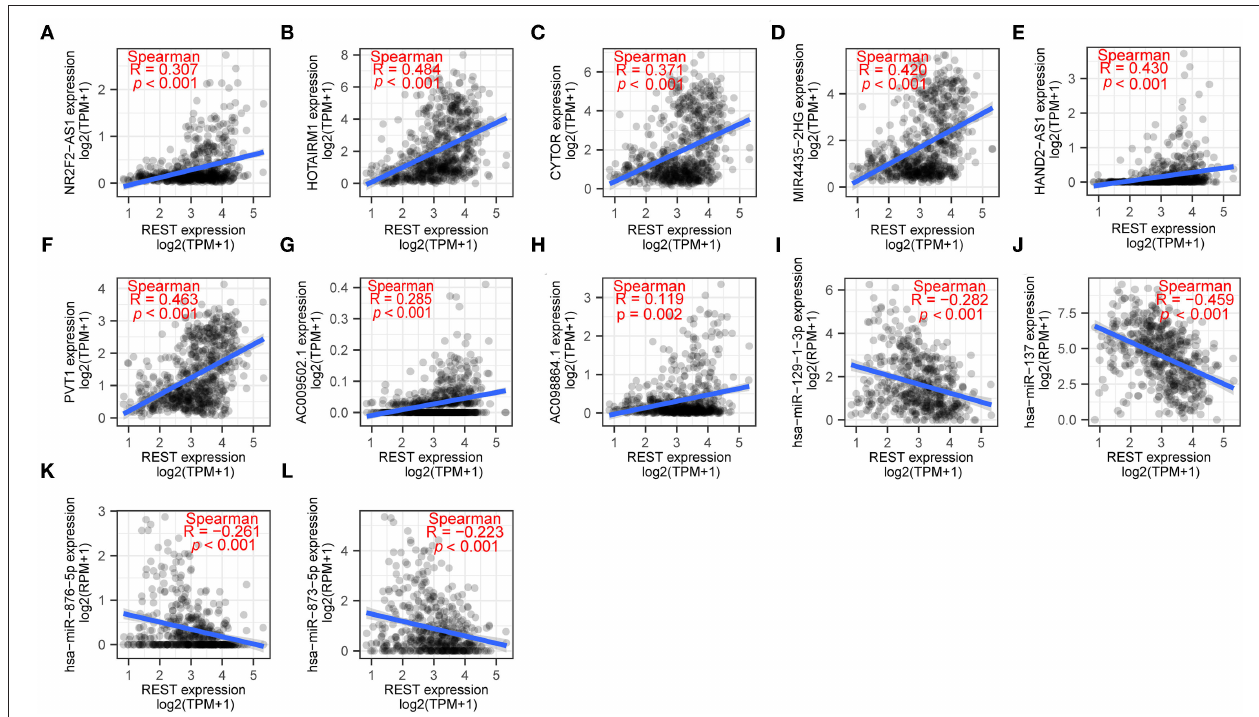
FIGURE 6 | The correlation of REST and its hub genes of ceRNA network. The correlation between REST and NR2F2-AS1 (A) , HOTAIRM1 (B) , CYTOR (C) , MIR4435-2HG (D) , HAND2-AS1 (E) , PVT1 (F) , AC009502.1 (G) , AC0098864.1 (H) , hsa-miR-129-1-3p (I) , hsa-miR-137 (J) , hsa-miR-876-5p (K) , hsa-miR-873-5p (L) . Data were analyzed using Spearman rank